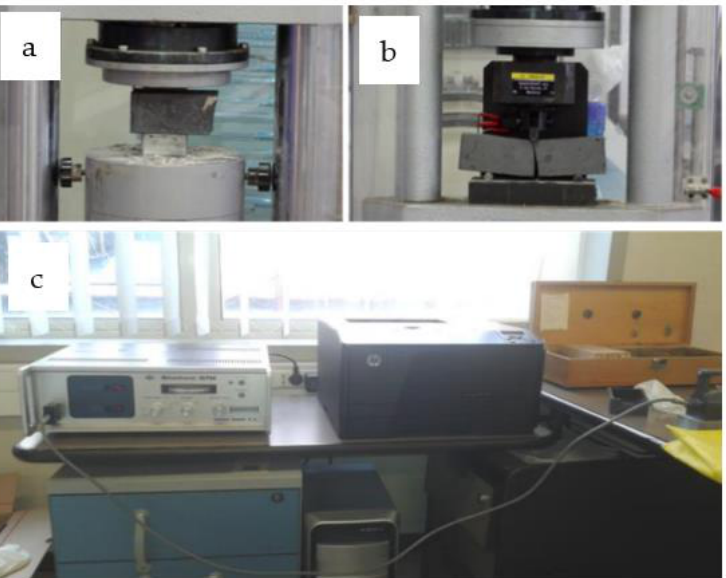
Figure 1. ( a , b ) Samples preparation and ( c ) standard and doped (ST with 5% of CFP) bentonitic grout samples.